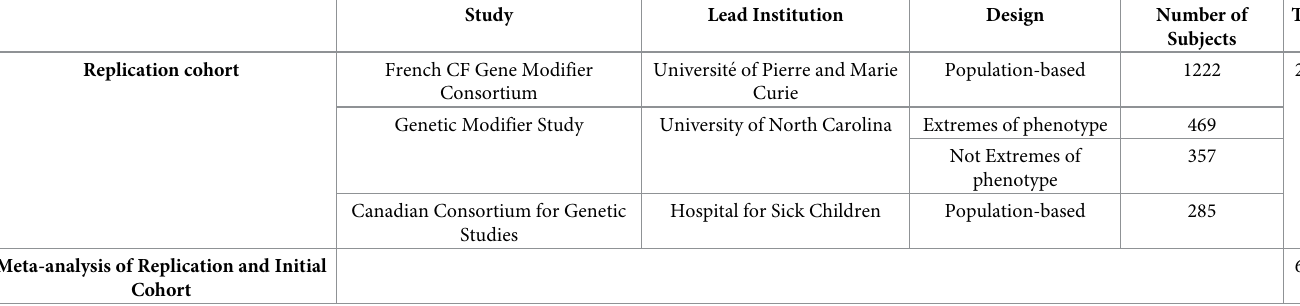
Table 1. Characteristics of the individuals included in the replication and meta-analysis of rs1078761.